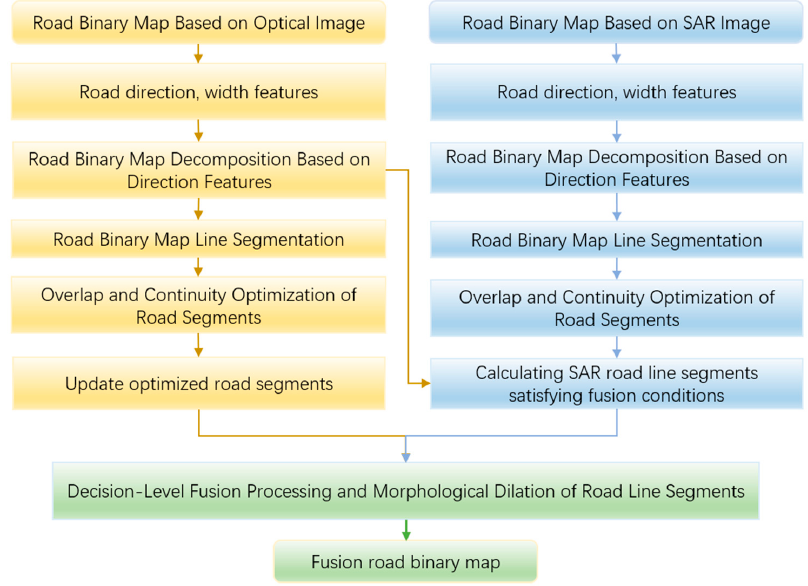
Figure 12. The detailed workflow of the decision level fusion.